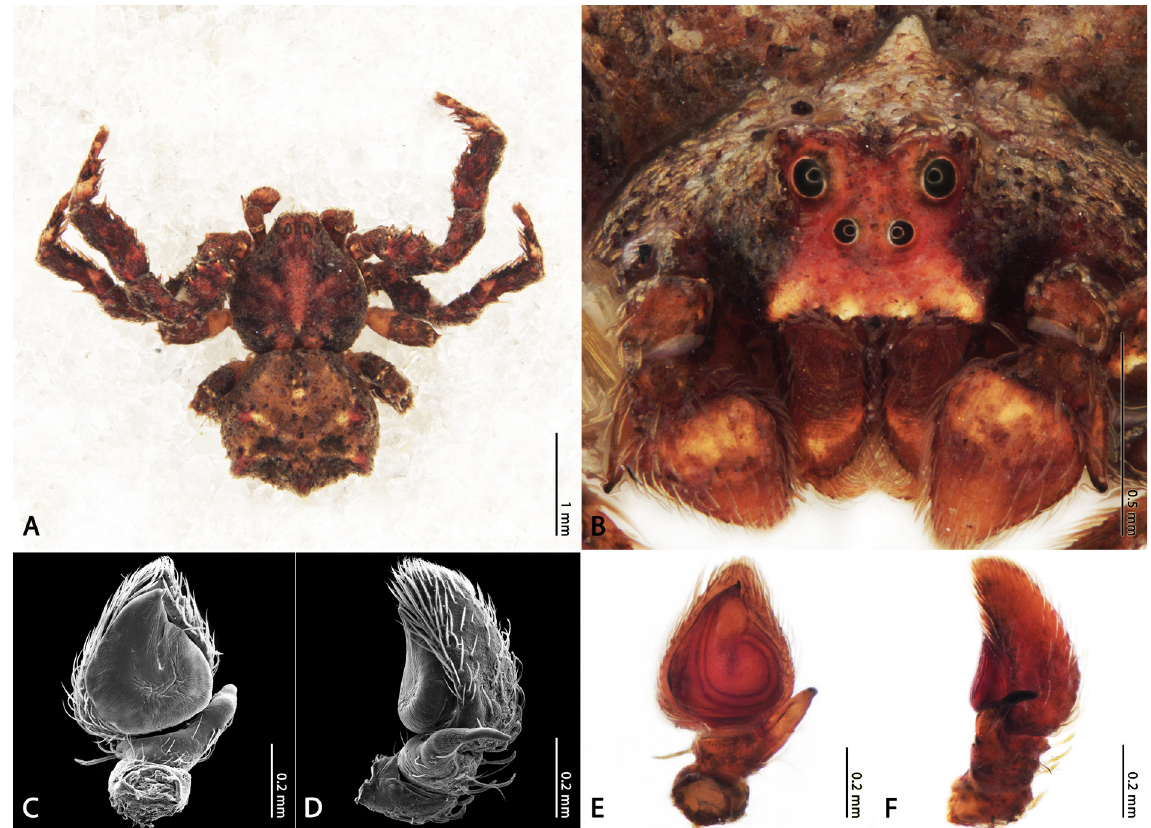
Fig. 15. Male of Kryptochroma renipalpis (Mello-Leitão, 1929) gen. et comb. nov. (MCTP 42730). A . Habitus, dorsal view. B . Front. C–F . Left male palp. C, E . Ventral view. D, F . Retrolateral